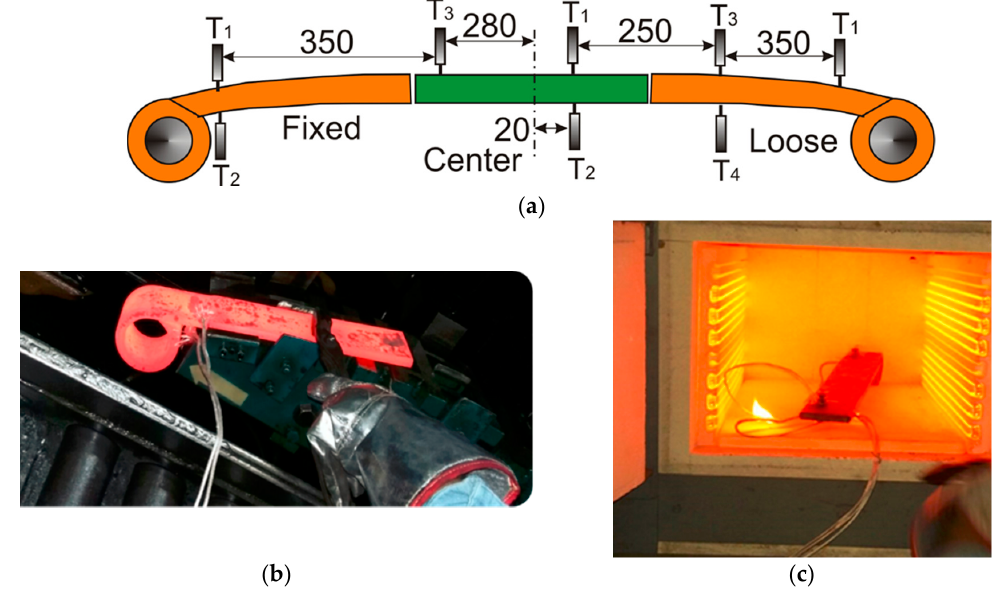
Figure 3. ( a ) Schematic representation of sectioned leaf spring indicating thermocouple locations in millimeters, and photographs of ( b ) preheated fixed section being placed in shaper table and ( c ) loose section being preheated in a muffle.